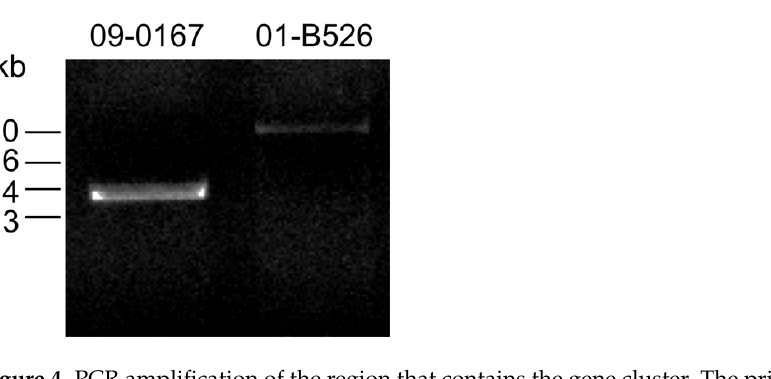
Figure 4. PCR amplification of the region that contains the gene cluster. The primers PEM_INS1-F and PEM_INS2-R were used (see Figure 3 for their position on the chromosome). Based on genomic analysis, the 01-B526 strain contains the gene cluster while the 09-0167 strain does not. Following genomic analysis, the 69 strains of A. salmonicida subsp. salmonicida from Table 1 and Table S3 were tested to see if they contain the gene cluster by using primer pairs that target genes ASA_2927, ASA_2930, and ASA_2933 (Figure 3). Table 2 shows that the gene cluster is present in all the AsaGEI1a -bearing strains and all the strains without AsaGEI originating from outside Canada. For the AsaGEI2a strains and the Quebec strains without AsaGEI , the gene cluster is absent. For strains that do not have the gene cluster, the same 3.7 kb as for the 09-0167 strain is obtained with the PEM_INS1-F and PEM_INS2-R primers (Figure 4). All these results propose a link between TTSS loss and the presence of the gene cluster. The only group of strains where this conclusion does not fit is for the strains bearing an AsaGEI2a without prophage 3. Based on Table 1 and Table S3, from the 8 strains of this group that were analyzed, three can lose their TTSS, even if the gene cluster was not detected in their genome. Table 2. Correlation between the presence of the ASA_2927 to ASA_2933 genes and certain groups of A. salmonicida subsp. salmonicida .